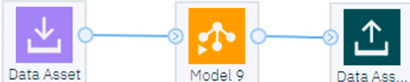
Sensors 2019 , 19 , 1407 Figure 15. Watson Studio with the data stream developed in IBM SPSS Modeler. Figure 15. Watson Studio with the data stream developed in IBM SPSS Modeler.